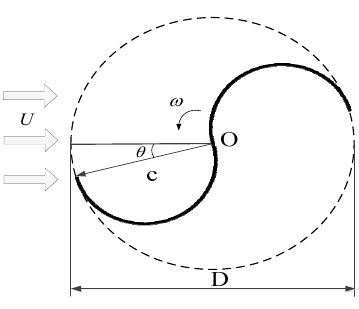
Figure 1. 2D schematic of the Savonius turbine.